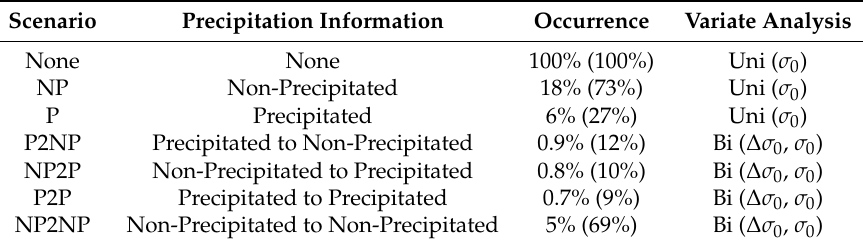
Table 2. Precipitation information scenarios, with acronyms used as references. The occurrences show the percentages of detected precipitation condition with respect to the total number of extracted samples. The occurrences between parentheses show the same, but normalized relative to their grouped sum. The variate analysis indicates which variables are used for